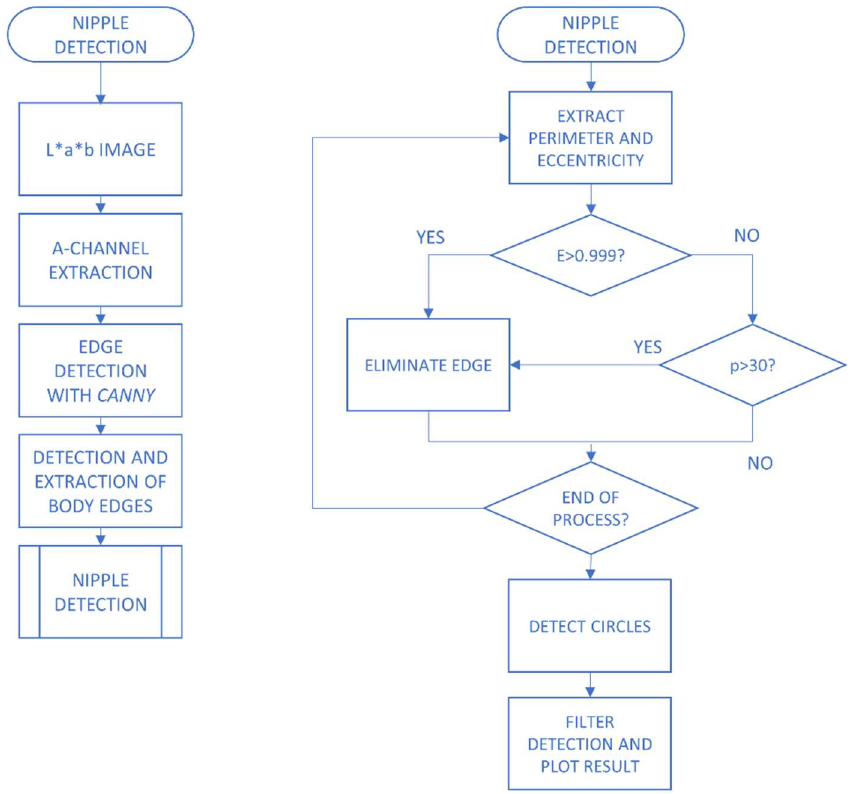
Figure 4. Routine and subroutine for nipple detection.